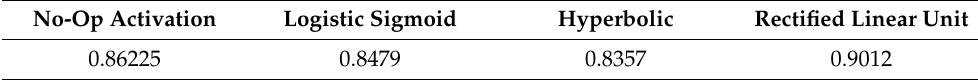
Table 4. Comparison of the effectiveness of activation